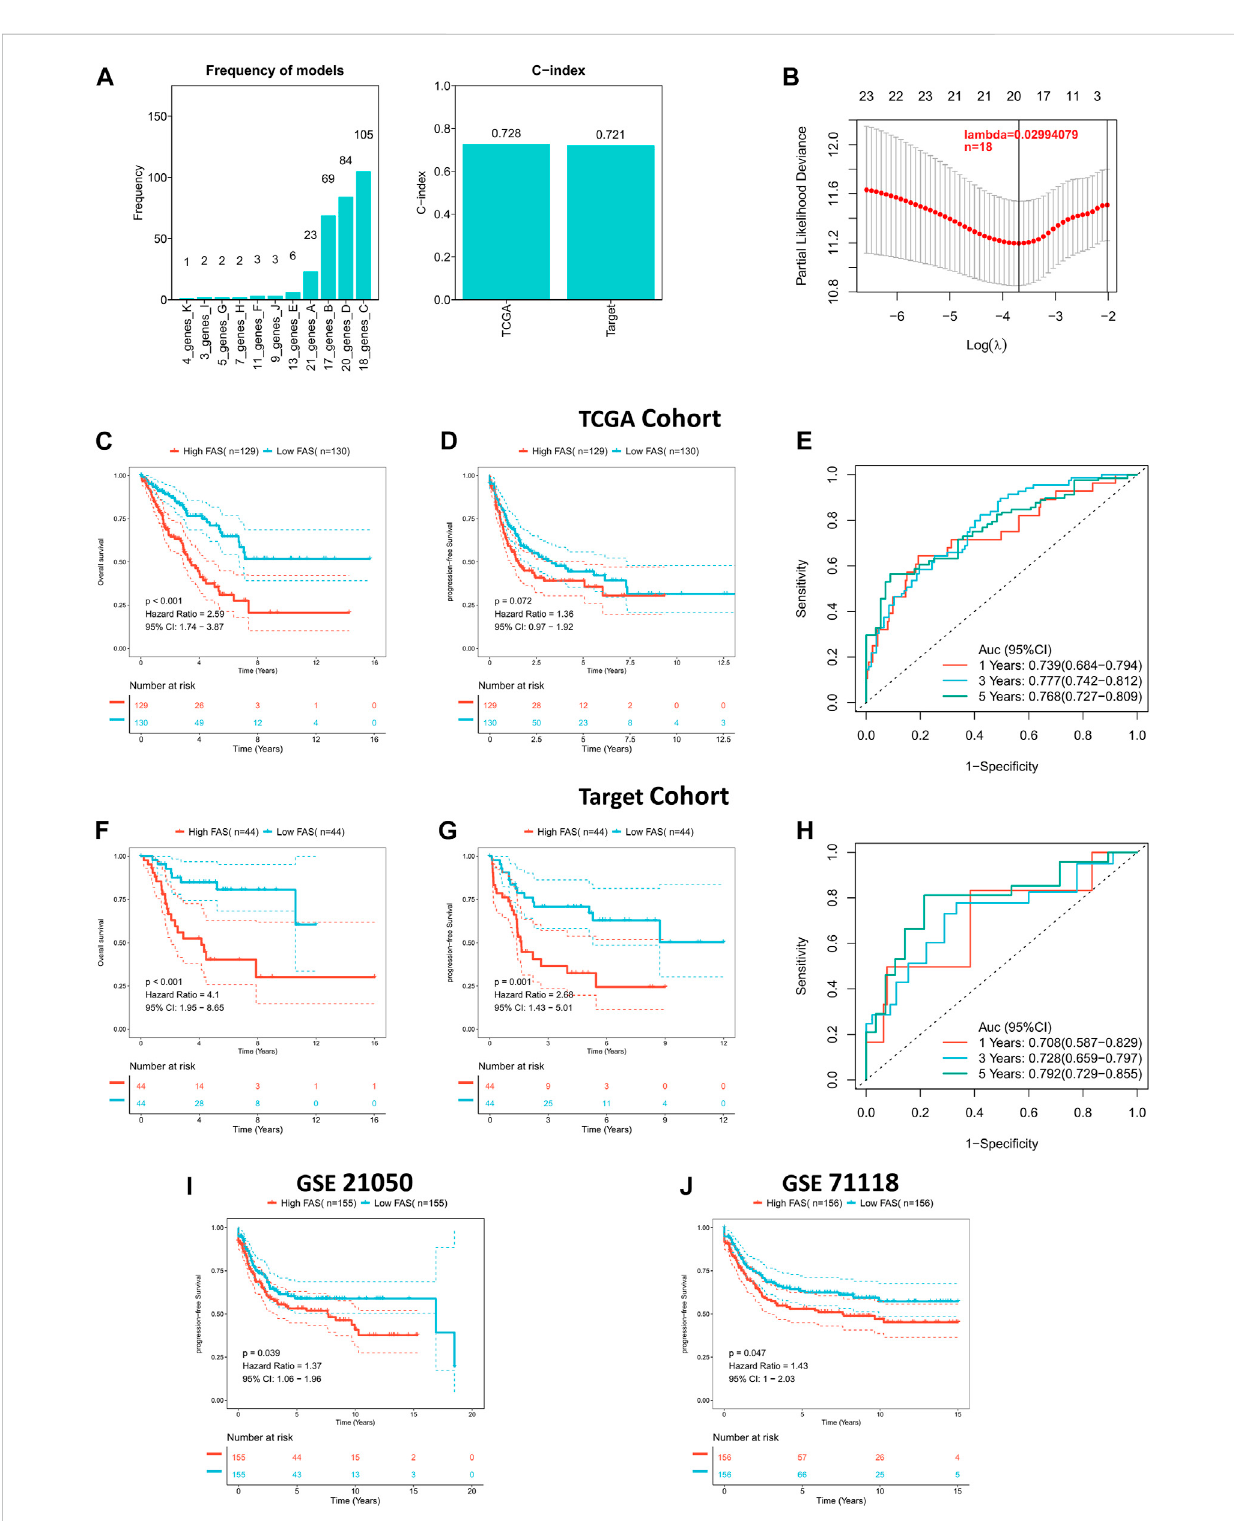
FIGURE 3 Constructionofthefattyacidmetabolismriskscore(FAS)inSTS. (A) ThefrequencyandC-indexofFASconsistedof18fattyacidmetabolism-related genes. (B) LASSO coef fi cient pro fi le analysis to identify the most helpful risk score system. (C) Kaplan ‒ Meier curves of OS in the TCGA cohort based on FAS. (D) Kaplan ‒ Meier curves of PFS in the TCGA cohort based on FAS. (E) ROC results of the FAS for the prediction of OS at 1, 3, and 5 years in the TCGA cohort. (F) Kaplan ‒ Meier curves of OS in the TARGET cohort based on FAS. (G) Kaplan ‒ Meier curves of PFS in the TARGET cohort based on FAS. (H) ROC results of the FAS for the prediction of OS at 1, 3, and 5 years in the TARGET cohort. (I) Kaplan ‒ Meier curves of PFS in GSE21050 based on FAS. (J) Kaplan ‒ Meier curves of PFS in GSE71118 based on